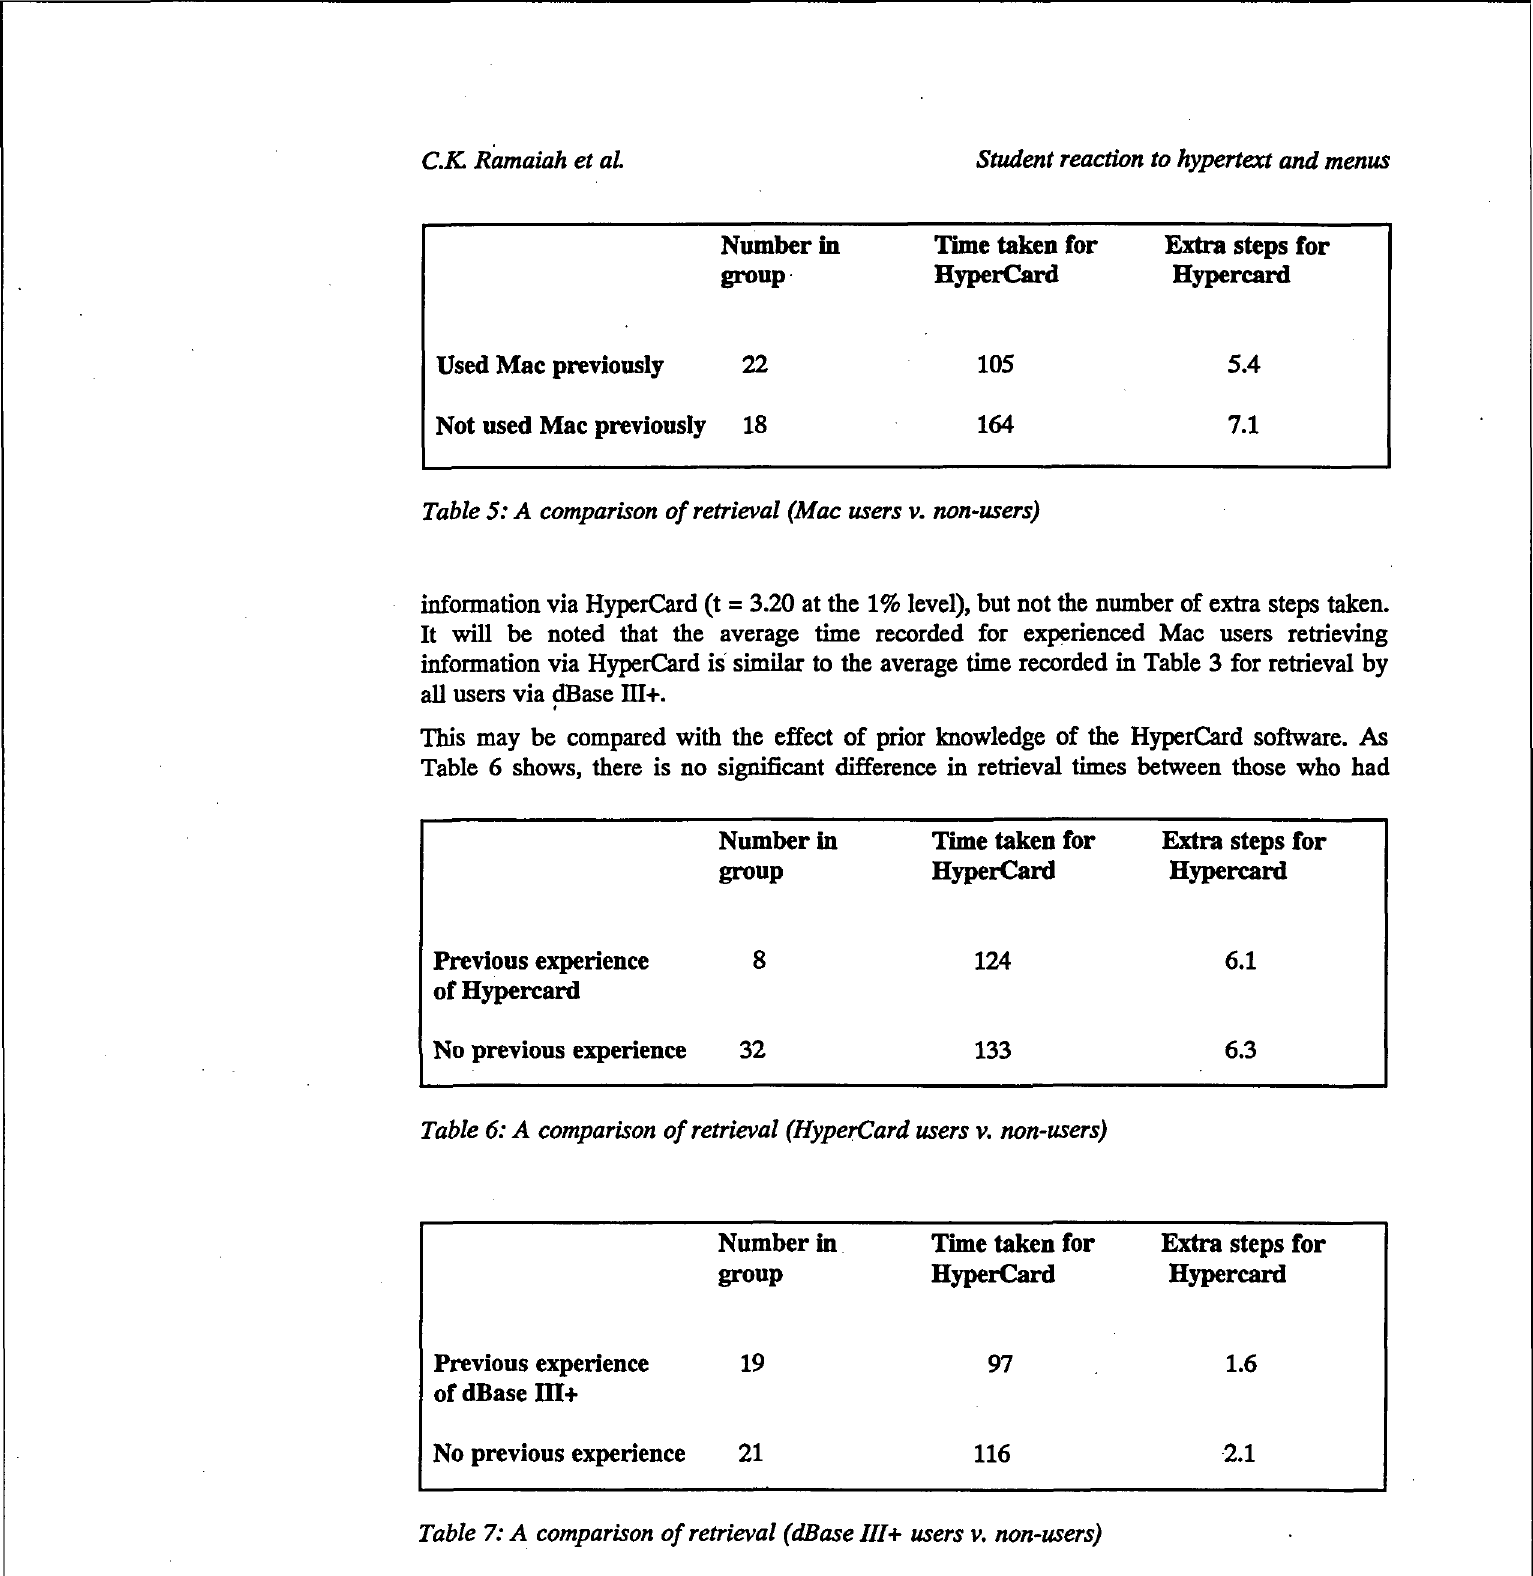
Table 7: A comparison of retrieval (dBase III+ users v.